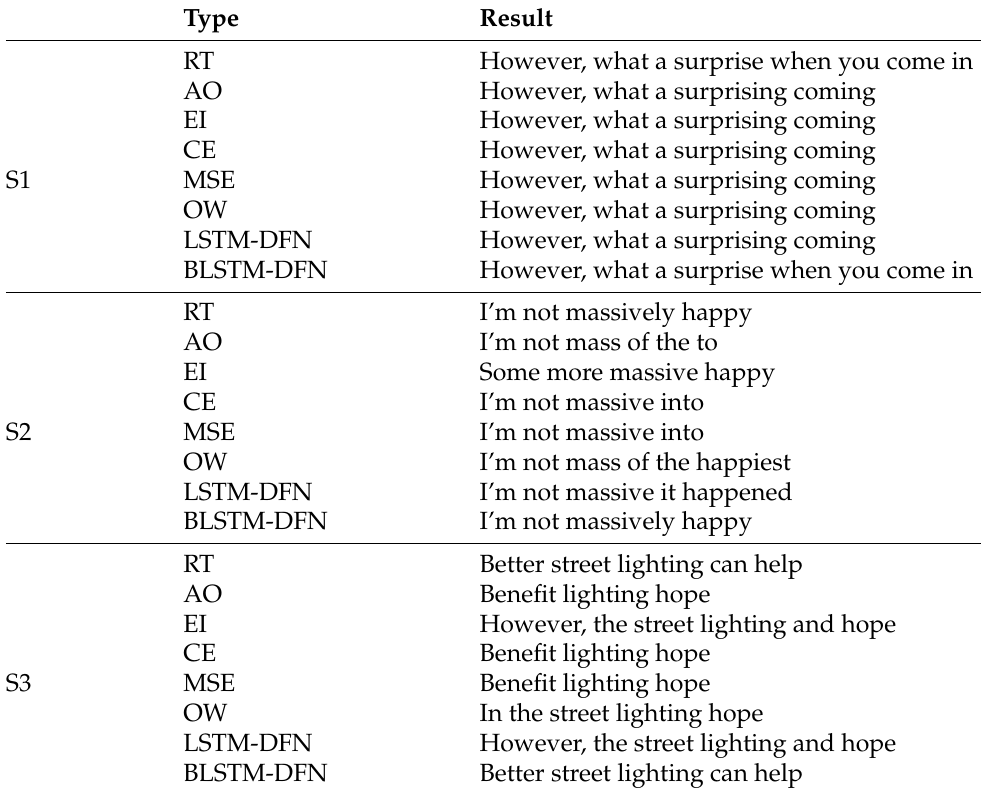
Table 3. Decoding results for three exemplary sentences S1, S2 and S3. RT represents the reference transcription; AO is audio only model; EI is early integration; CE and MSE represent dynamic stream weighting with CE and MSE as loss functions; OW is the oracle stream-weighting; and LSTM-DFN and BLSTM-DFN are variants of our proposed integration